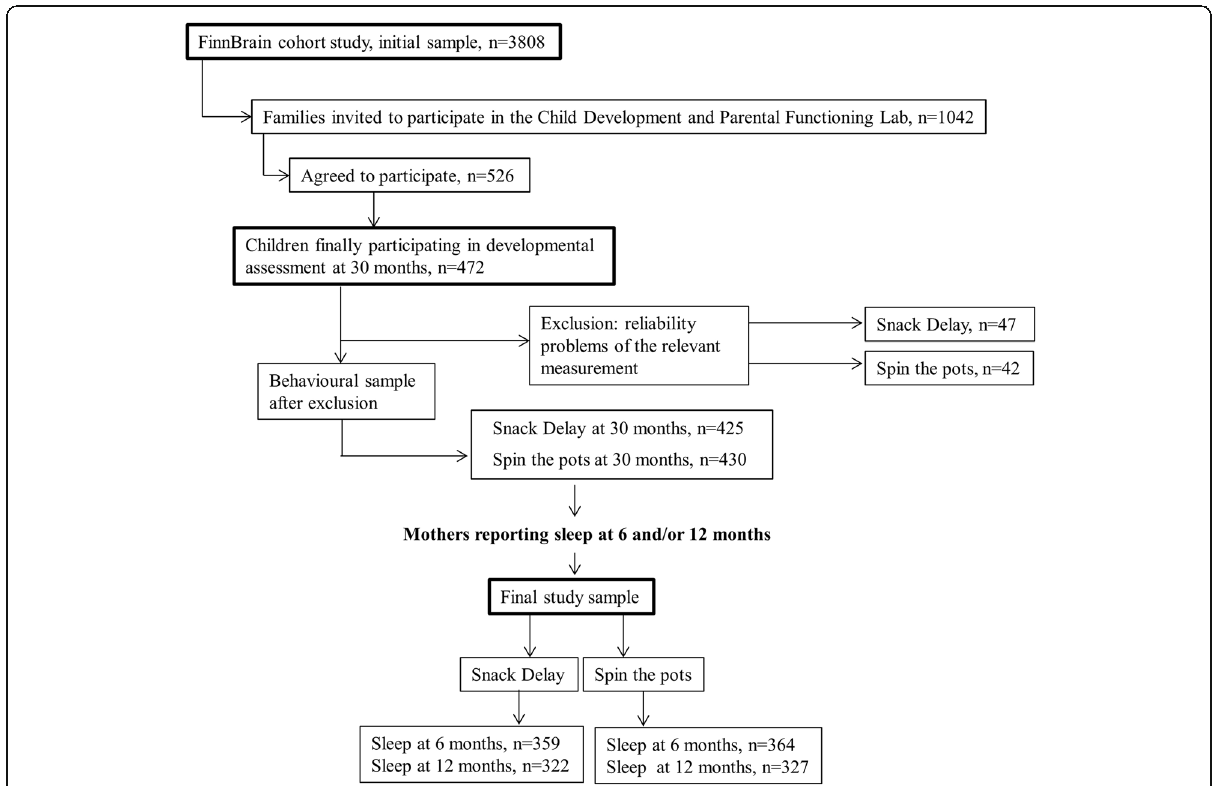
Fig. 1 Flowchart of sampling procedure and exclusion criteria. This figure shows how the final sample for this study was selected. Initially, 472 children participated in the developmental assessment and from them, 47 children in Snack Delay and 42 children in Spin the Pots were excluded from the final analyses due to reliability problems of the relevant measurement. Furthermore, only those children of the remaining sample whose mothers reported on sleep at 6 and/or12months were included in the final analyses, resulting in the following samples: i) for IC task, 359 infants with sleep questionnaire at 6 months and 322 with sleep questionnaire at 12 months; and ii) for WM task at 30 months, 364 infants with sleep questionnaire at 6 months and 327 with sleep questionnaire at 12